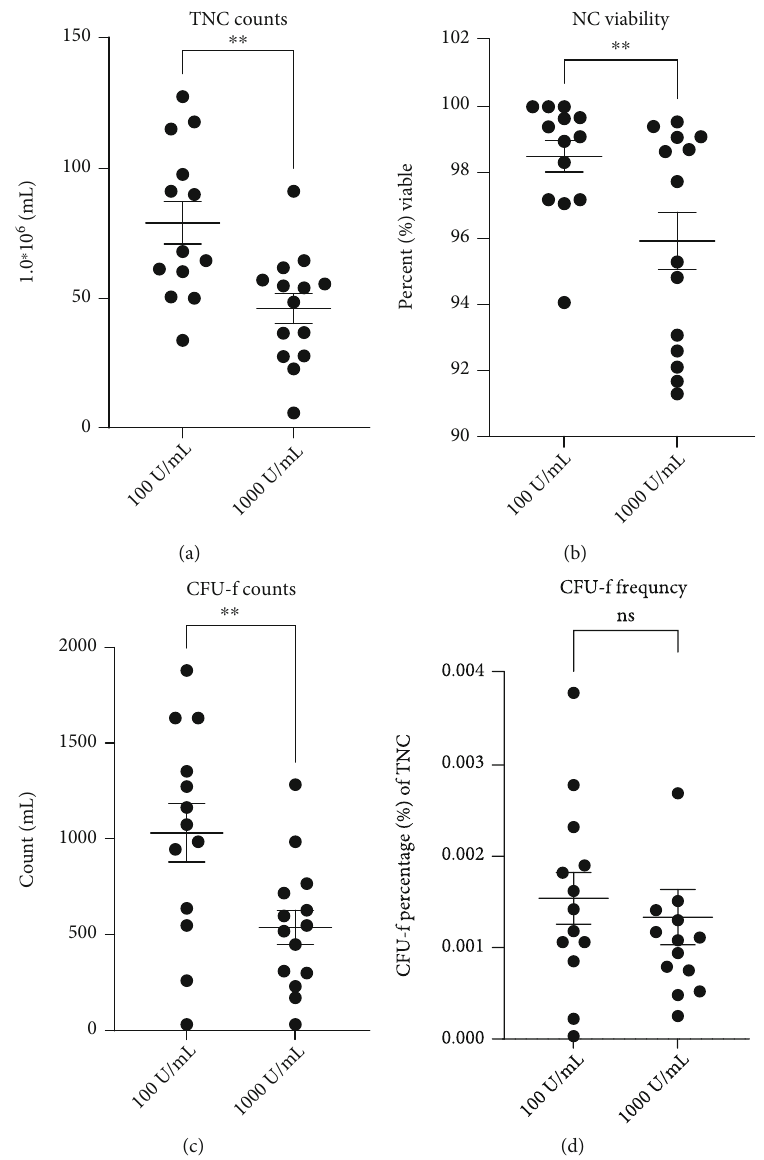
Figure 4: Comparison of BMC characteristics derived from 100 U/mL heparin sodium (100U/mL) and 1,000U/mL heparin sodium (1,000 U/mL). Comparisons between the respective BMCs: (a) total nucleated cell (TNC) count per mL, (b) nucleated cell (NC) viability, (c) colony-forming units with fi broblast morphology (CFU-f) counts per mL, and (d) frequency of CFU-f amongst the TNC population. Graphs display the population mean and standard error of the mean. ns: not signi fi cant, ∗ P < 0 : 05 and ∗∗ P < 0 : 01